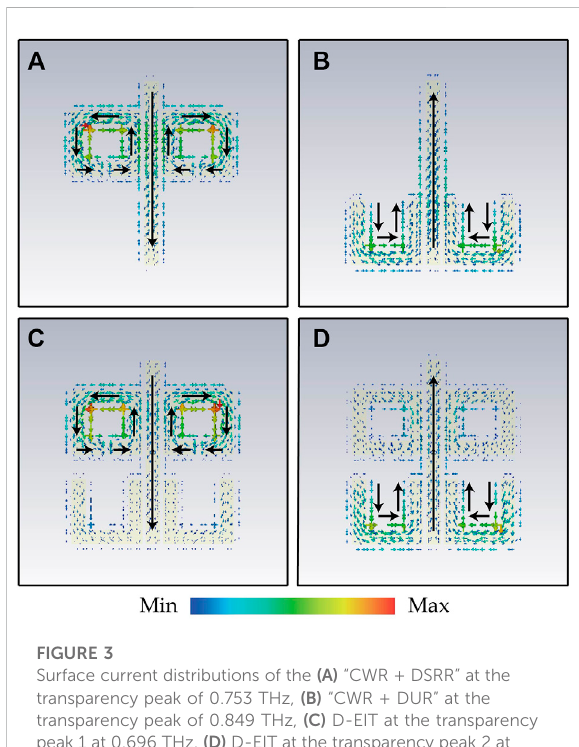
FIGURE 3 Surface current distributions of the (A) “ CWR + DSRR ” at the transparency peak of 0.753 THz, (B) “ CWR + DUR ” at the transparency peak of 0.849 THz, (C) D-EIT at the transparency peak 1 at 0.696 THz, (D) D-EIT at the transparency peak 2 at 0.954 THz, under the y -polarized